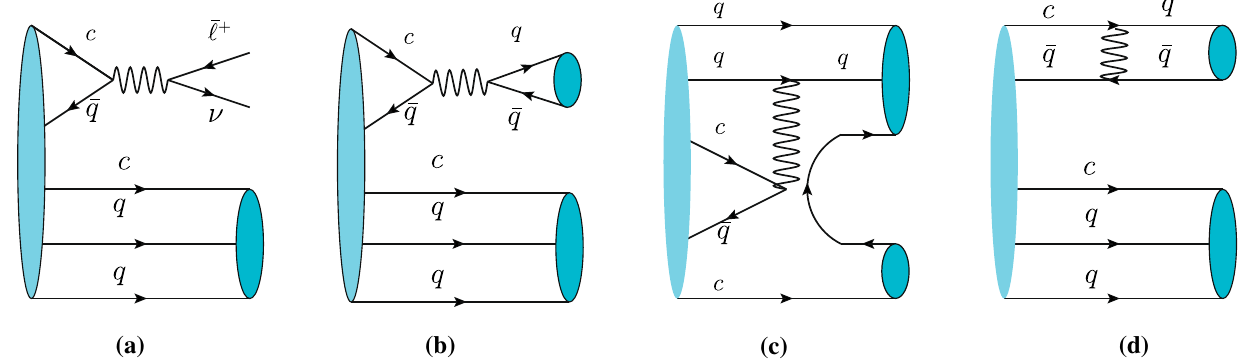
Fig. 4 The weak decay diagrams of the doubly heavy pentaquark P 6 are given in ( a – d ), which semi-leptonic decays to be ( a ), non-leptonic decays to be ( b – d )